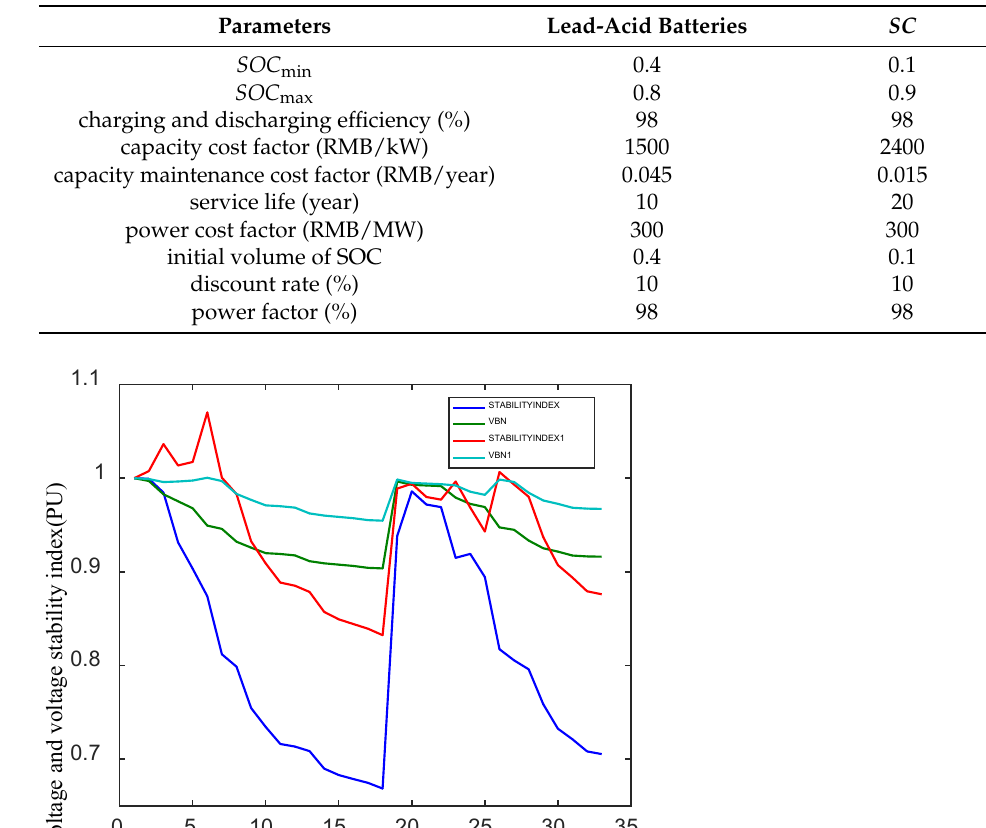
Table 1. Related parameters of the energy storage unit.